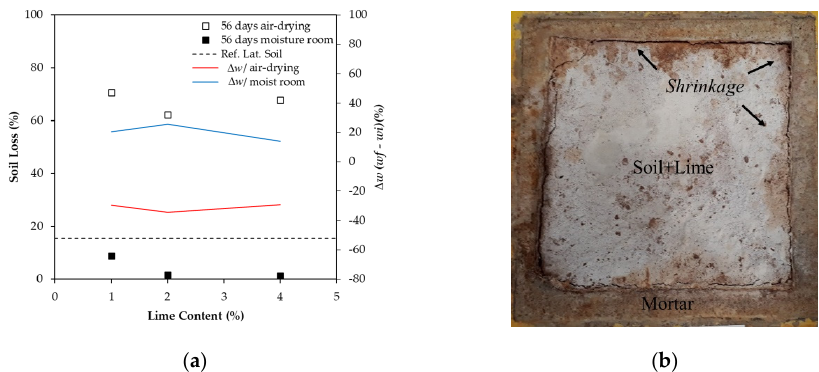
Figure 7. ( a ) Comparison of the performance of soil–lime stabilization under different curing storage conditions. ( b ) Sample holder with a 1% lime sample after 28 days showing border shrinkage by water content loss.